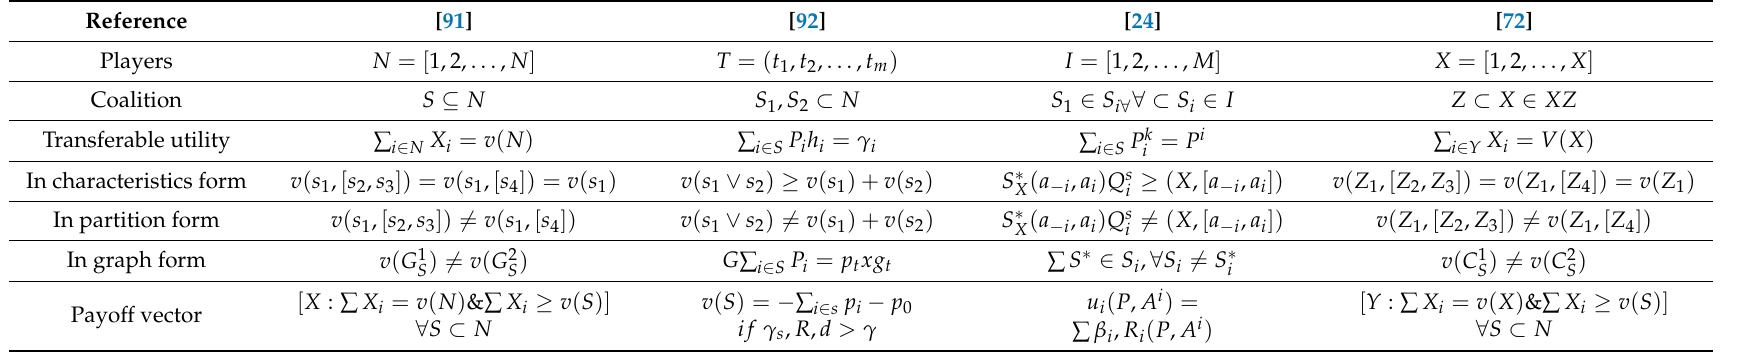
Table A6. Mathematical Comparison of Coalition